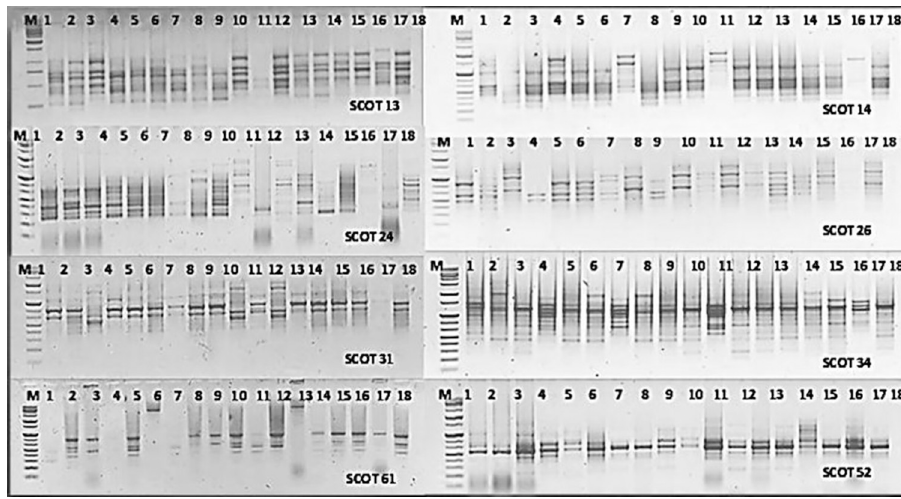
Fig 3. Amplification profile obtained with eleven ScoT primers in eighteen wheat genotypes. ( M) molecular marker (100 bp); lanes 1–18.